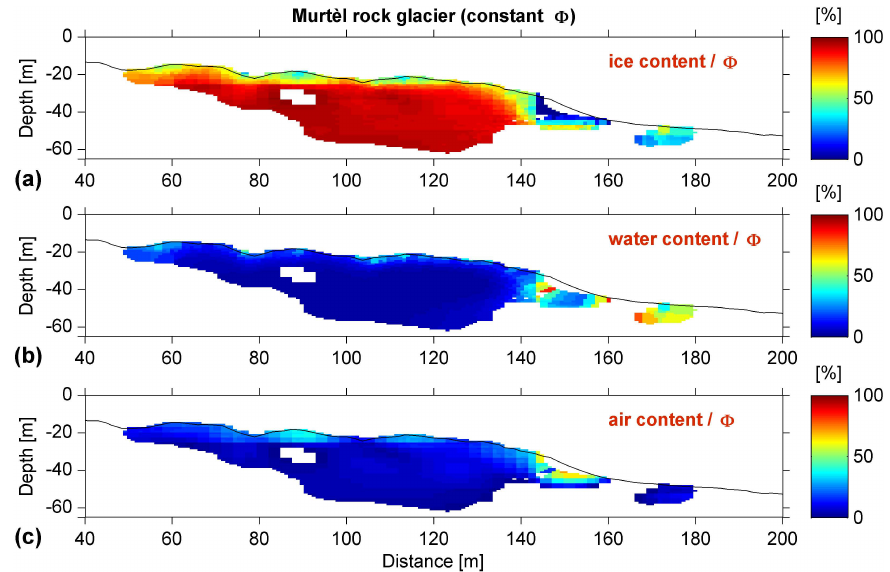
Fig. 12. As Fig. 11, but calculated relative to the available pore